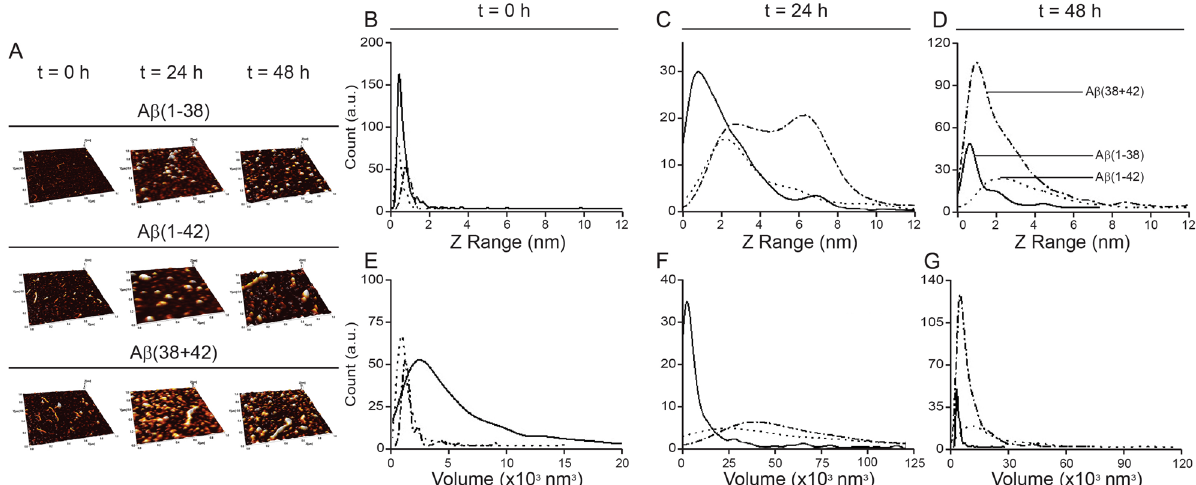
Figure 1. Aβ peptides incubate as aggregates with different properties in isolation or in a complex mixture. ( A ) AFM scans of surfaces used to measure the length ( B–D ) and volume ( E–G ) of aggregates derived from 20 µM solutions of the peptides alone, e.g. Aβ(1–38) (solid line) and Aβ(1–42) (dotted line), or a 20:1 mix of Aβ(1– 42):Aβ(1–38) (dotdash line) at the zero ‘0 ′ time-point and at 24 and 48 h of